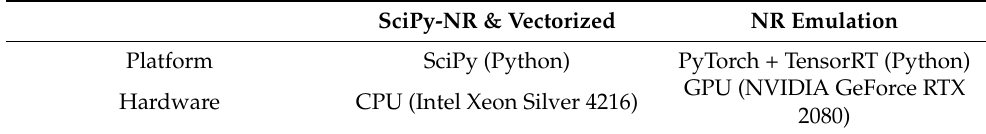
Table 2. Implementation platform and hardware.